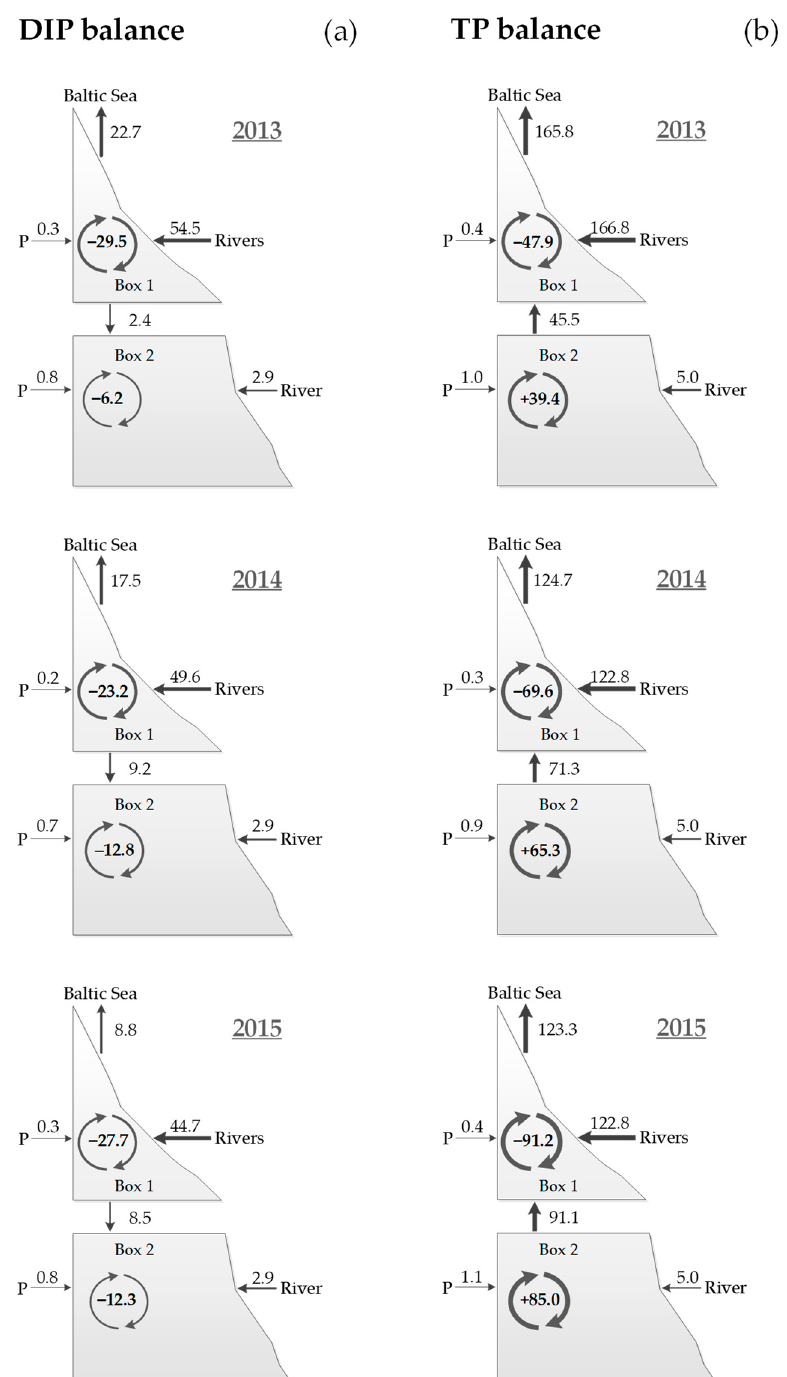
Figure 3. Dissolved inorganic (DIP) ( a ) and total phosphorus (TP) ( b ) budget for the Curonian Lagoon in 2013–2015. “P” is precipitation, “Rivers” includes Nemunas and Minija rivers plus Klaipeda WWTP that discharge in Box 1 and “River” is the Deima River that discharges in the southern area. Negative values in the internal transformations (round arrows within the grey areas) indicate retention (sinks) while positive values indicate production (sources). Units are 10 3 mol d − 1 .